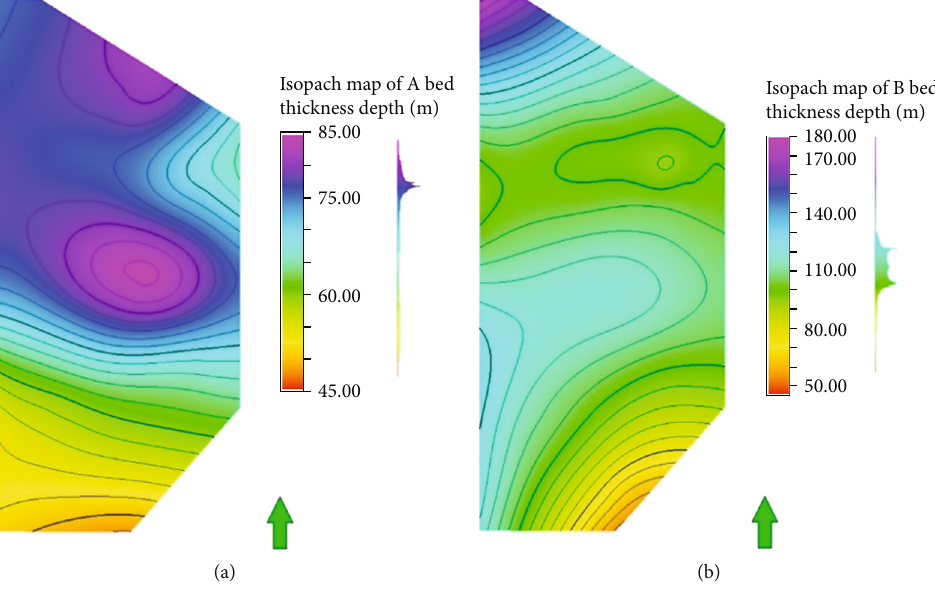
Figure 5: Isopach maps of the A shale bed (a) and the B shale bed (b). Thickness tends to increase toward the north, and relatively, the B bed is thicker than the A